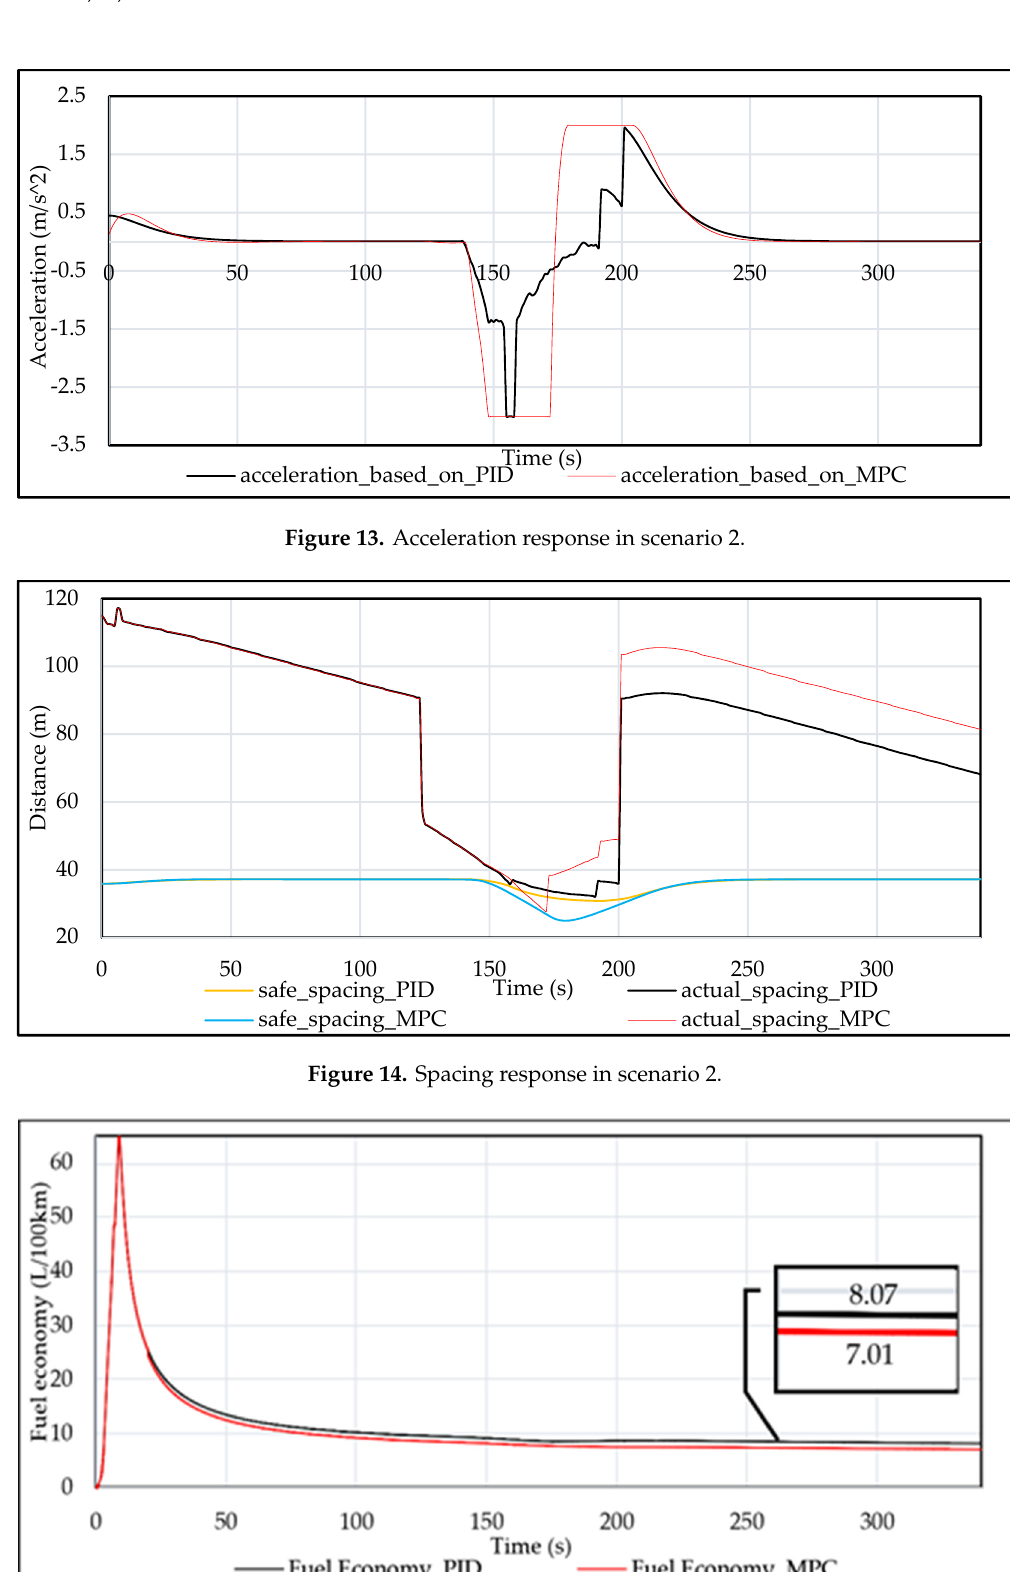
Figure 15. Fuel economy in scenario 2.